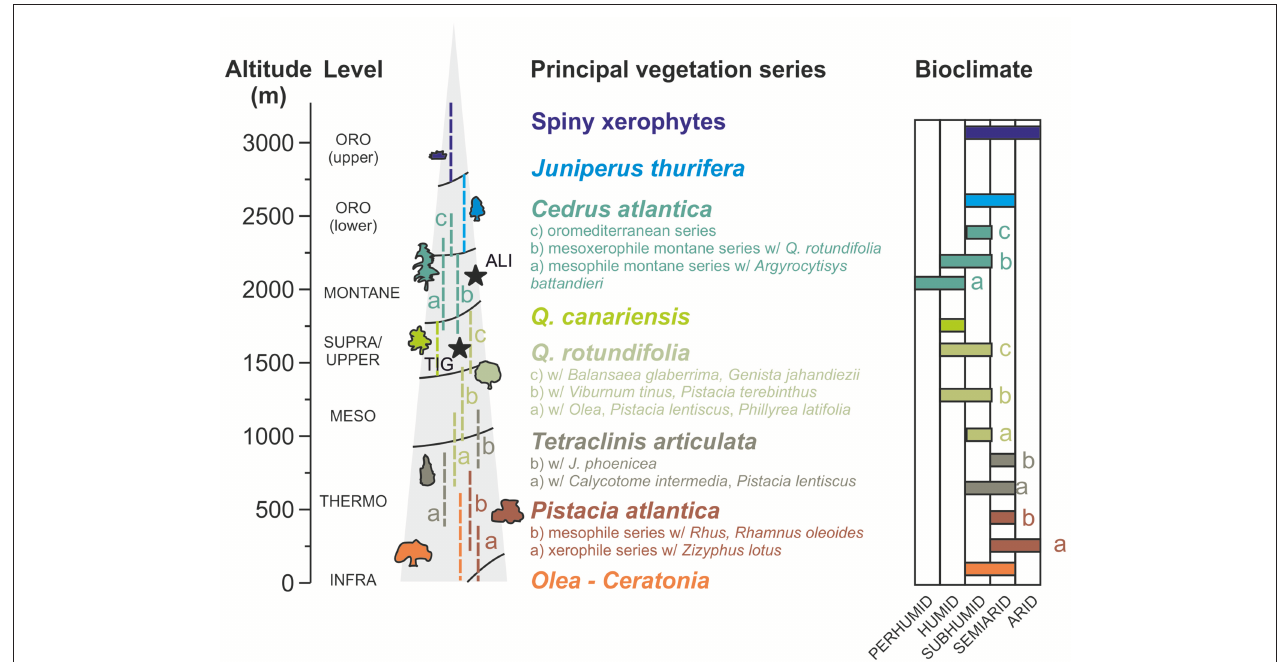
FIGURE 3 | Altitudinal distribution of the principal vegetation series of the Middle Atlas and their associated bioclimates, derived from Benabid (1982), showing the position of Lake Sidi Ali (ALI) and Tigalmamine (TIG).